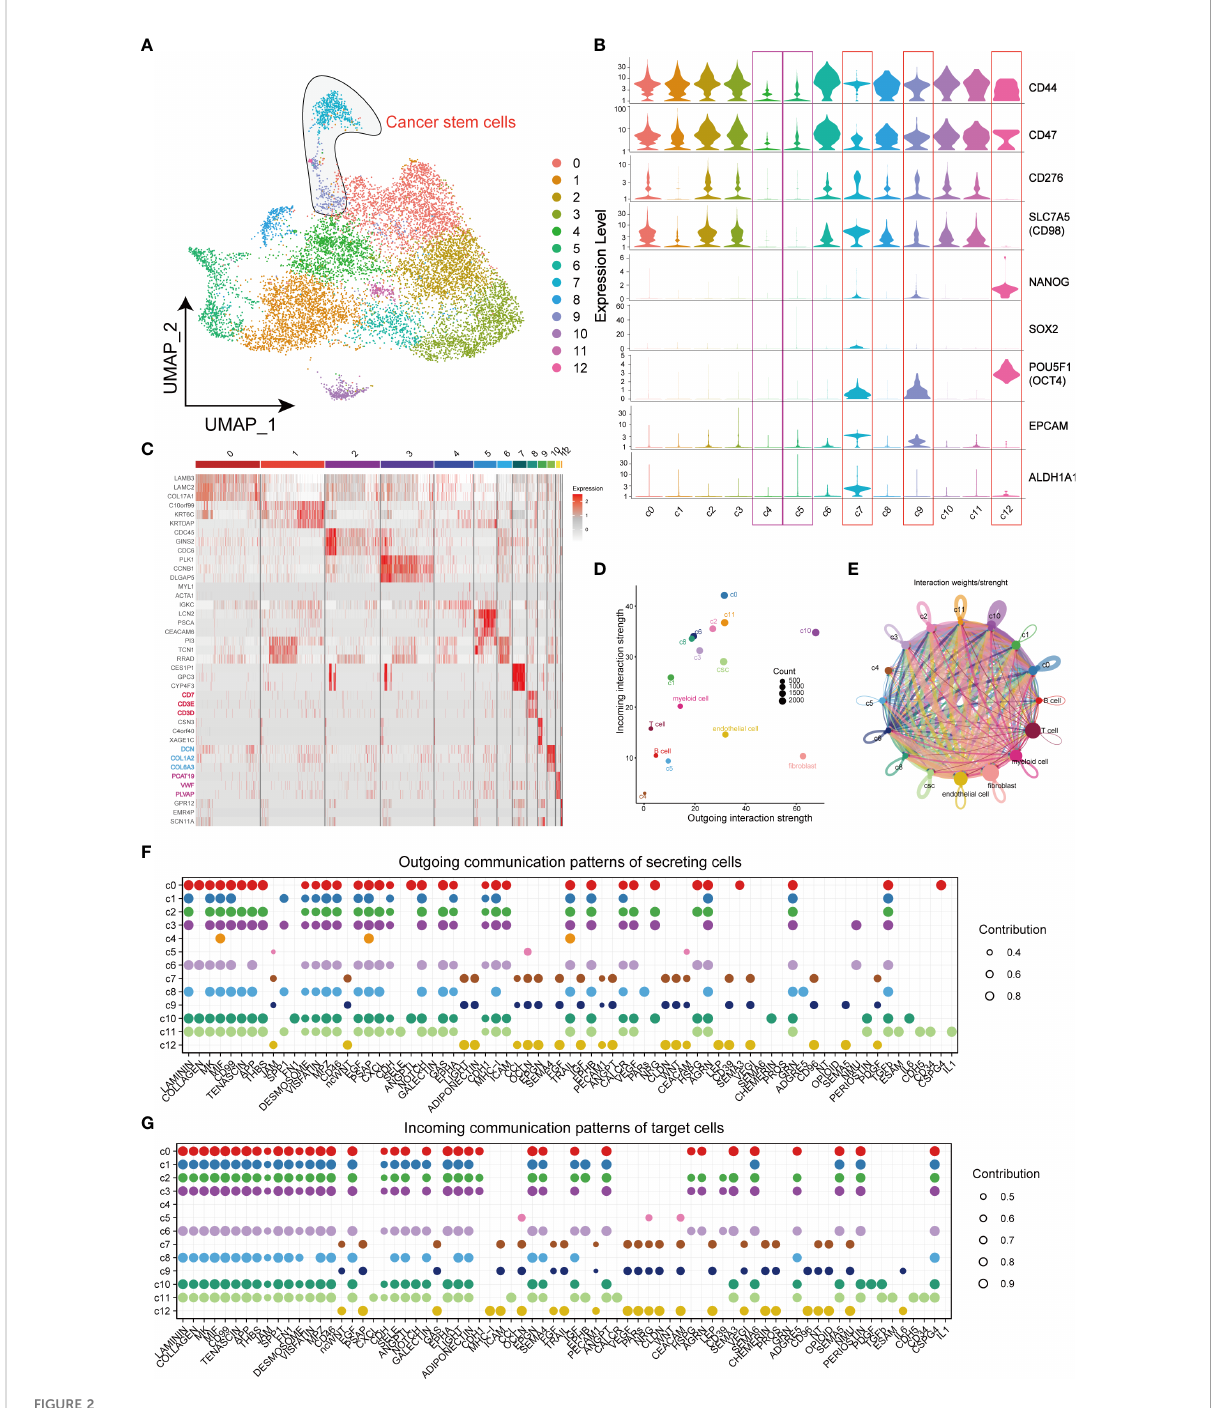
FIGURE 2 Landscape of characteristics of different clusters in cancer cells characterized by single-cell transcriptomic sequencing. (A) UMAP plot of 11858 cells in subgroup of cancer cells. (B) Violin plots of gene expression patterns of 13 cluster of cells types in subgroup of cancer cells. (C) Heatmap of the top three highest genes within 13 clusters of cancer cells. (D) Output/input interaction strength of different clusters of cancer cells and other types of cells in TME. (E) Weights/Strength of cell-cell interaction between different cell clusters of cancer cells. (F) Outgoing communication patterns of secreting cells. (G) Incoming communication patterns of secreting cells. Bubble size represents the strength of the